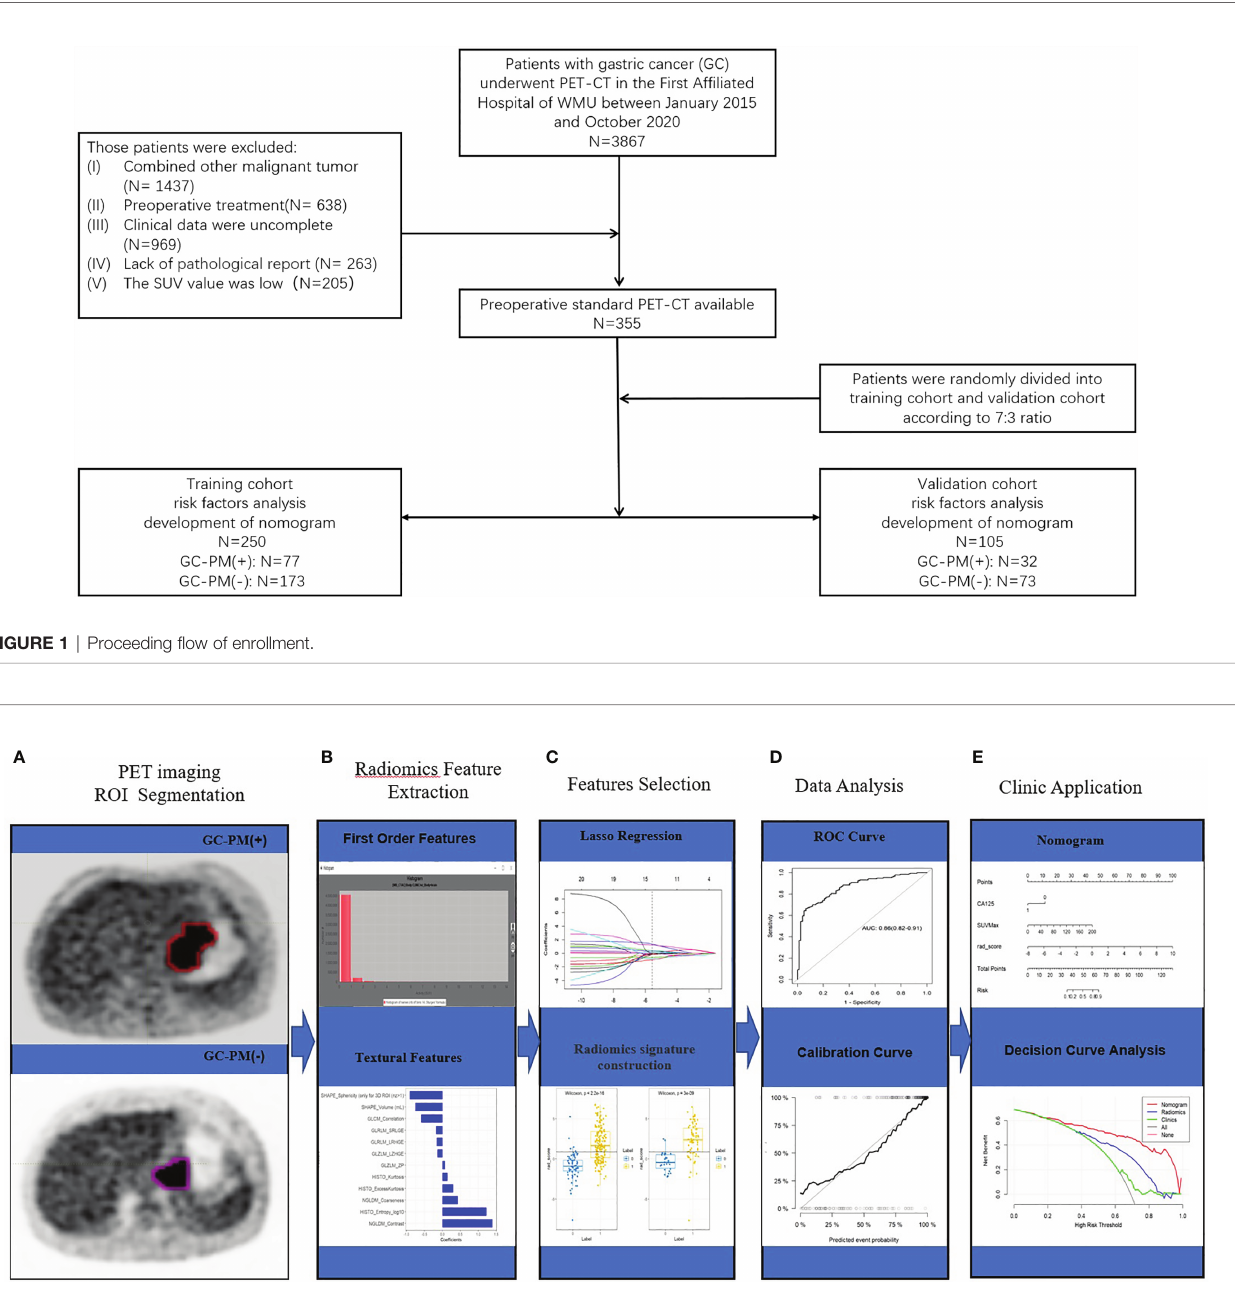
FIGURE 2 | Work fl ow. (A) PET imaging ROI segmentation. (B) Radiomic features are extracted by the LIFEx software with quali fi ed tumor intensity, shape, and texture. (C) PET feature selection using the mRMR and LASSO regularization. Rad-score was using Wilcoxon analysis for detecting the PM of GC. (D) The performance of the prediction model is assessed by the area under a receiver operating characteristic (ROC) curve and the calibration curve. (E) The PET radiomics nomogram with SUVmax, CA125, and radiomics signatures. Decision curve analysis for radiomics